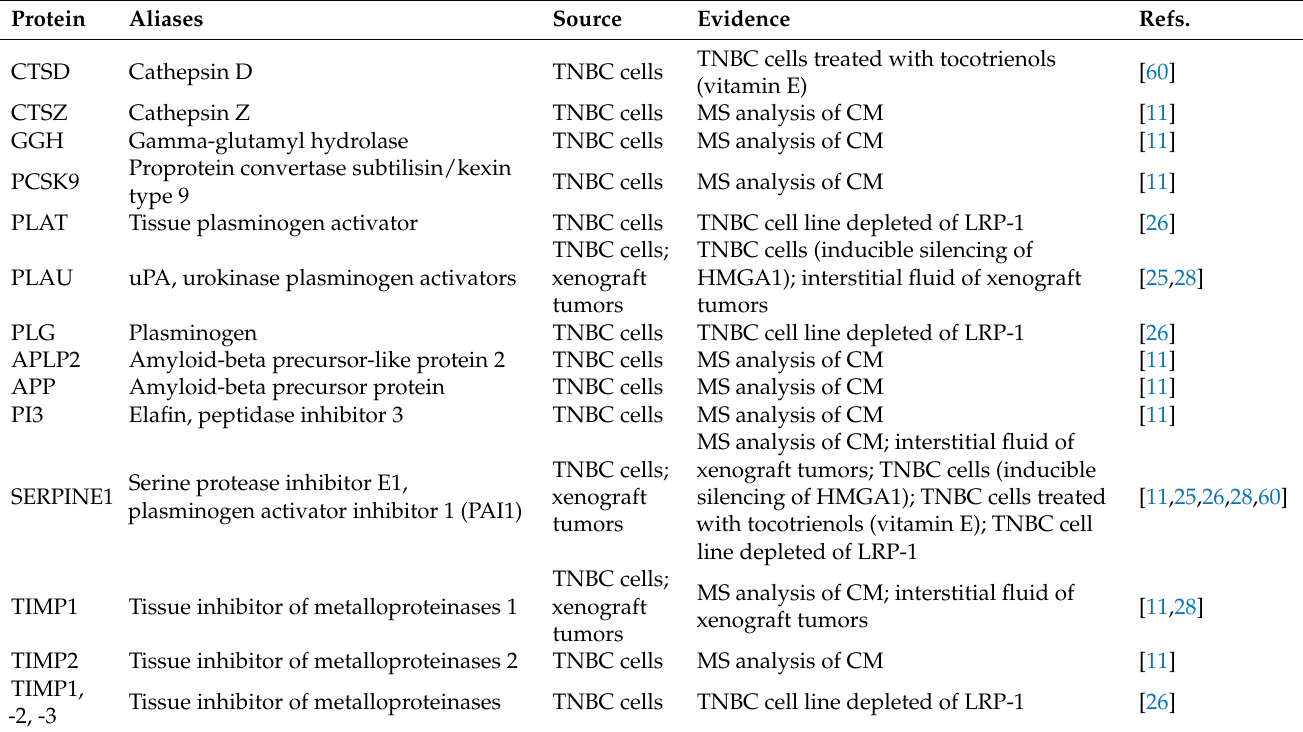
Table 3. Proteases and Protease Inhibitors of the TNBC